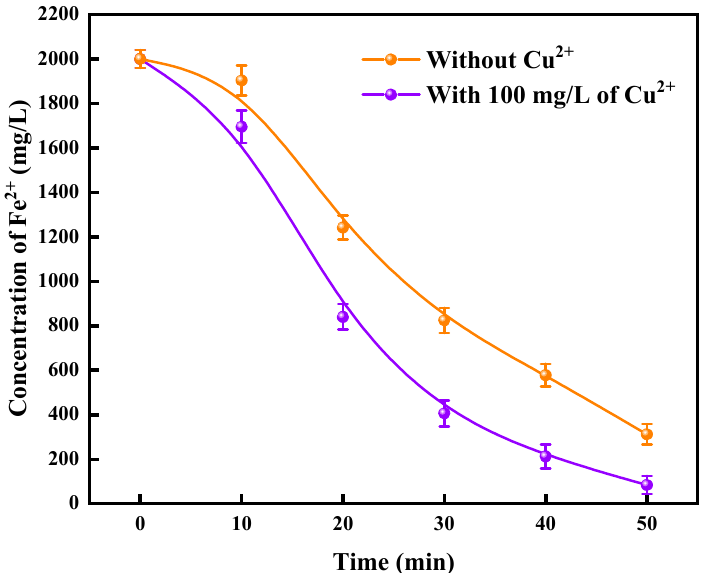
Figure 6. Influence of copper ions on the oxidation of ferrous ions.